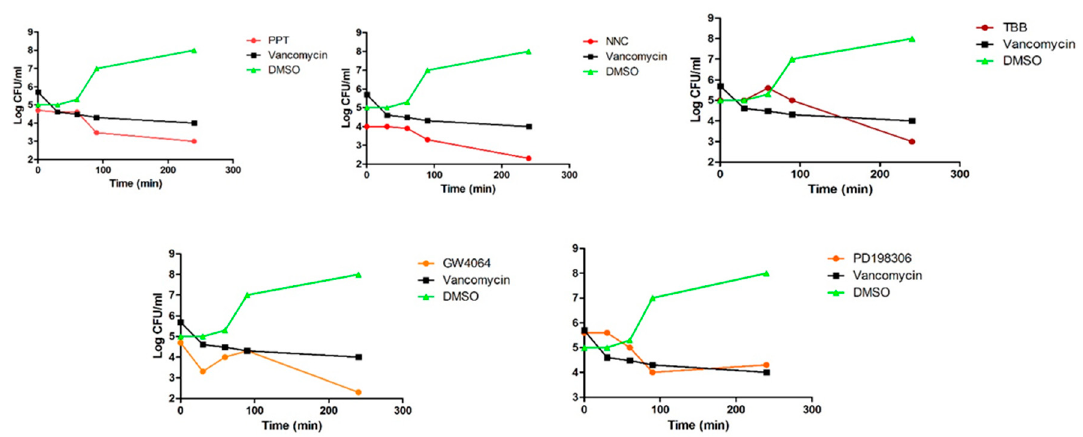
Figure 3. MRSA-MW2 cells were exposed to compounds at 64 µg/mL and cell viability was monitored over 4 hr. DMSO 0.64% and vancomycin (16 µg/mL) were included as controls.